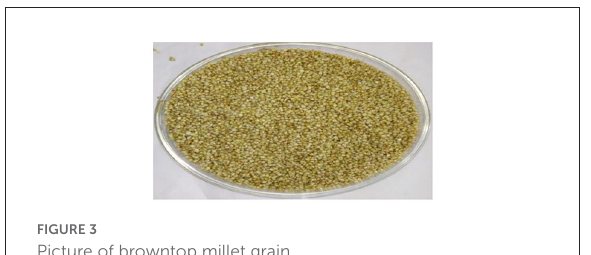
FIGURE3 Picture of browntop millet